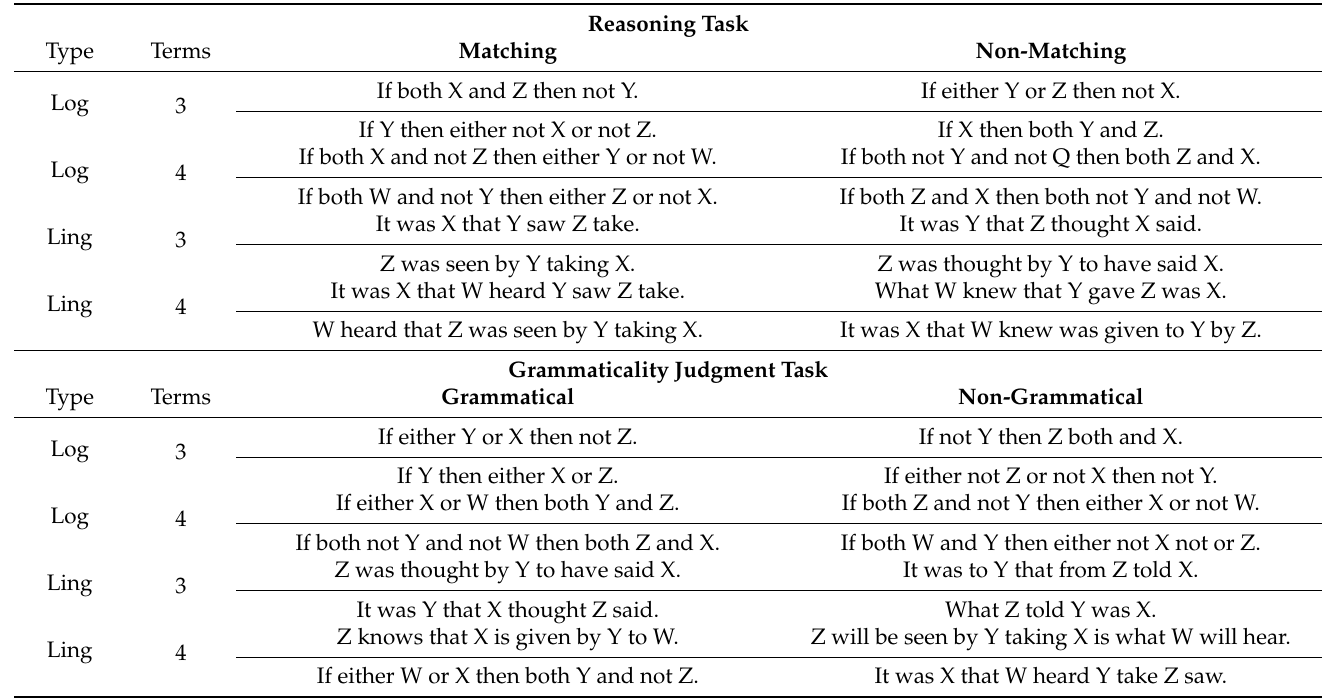
Table 1. Example stimuli. Sample logic and linguistic arguments presented in the reasoning and grammaticality judgment tasks (Abbreviations: Log, Logic; Ling,